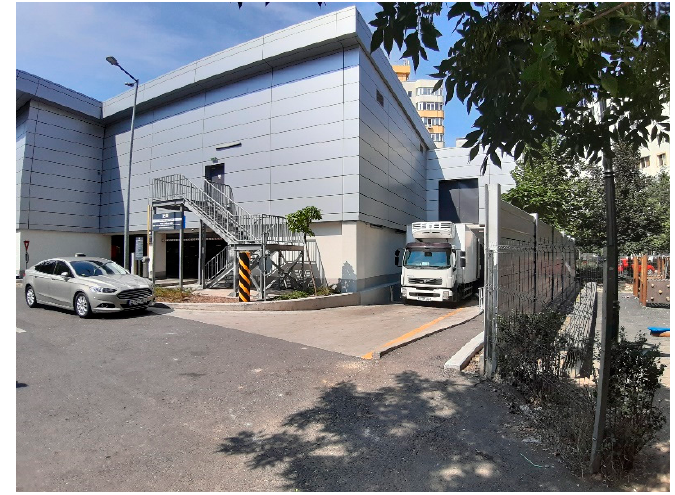
Figure 18. Supply ramp, acoustic barrier and shopping centre building.